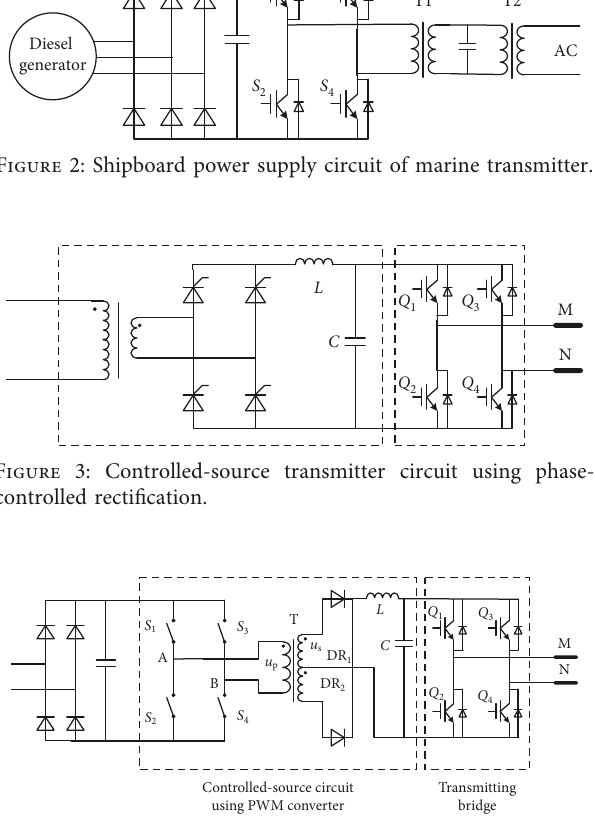
Figure 4: Transmitter circuit using PWM converter.